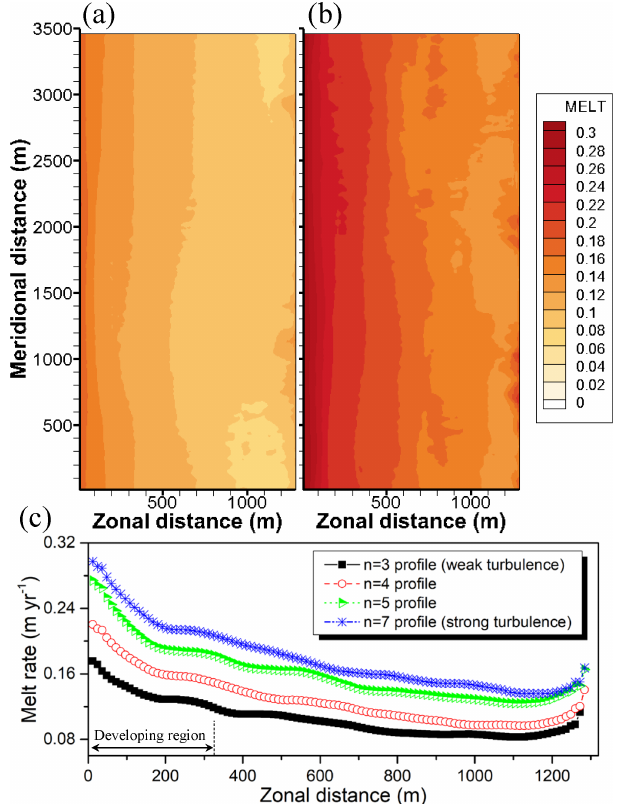
Figure 7. XY horizontal distribution of the 3 t ∗ time-averaged melt rate (myr − 1 ) at the ice-shelf base (280m). (a) Melting rate in the case of n = 3, weak turbulence. (b) Melting rate in the case of n = 7, strong turbulence. (c) Zonal–spatial distribution of the melt rate in four different turbulence cases. These values are averaged along the meridional